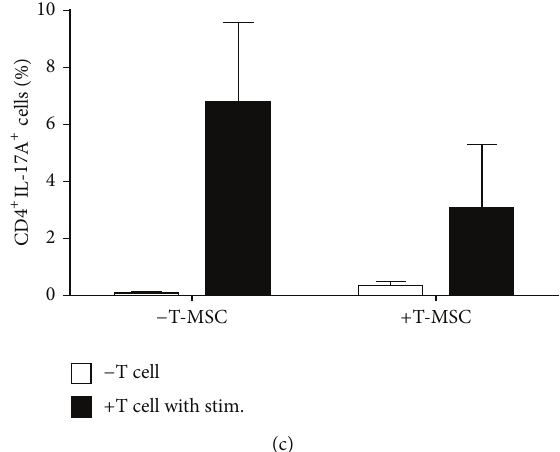
Figure 3: T-MSCs inhibit DC-mediated T cell proliferation and differentiation of the CD4 + T cell subset. (a) T cells were isolated from mouse spleens (BALB/c, 8-week-old, female) using MACS. (b) T cells were cocultured with mature DCs in the presence or absence of T- MSCs, and differentiation into CD4 + T cell subsets was induced using anti-CD3 and anti-CD28 antibodies. T cell numbers were increased upon coculturing with mature DCs. In the presence of T-MSCs, however, T cell proliferation was inhibited by 80%. (c) Differentiation into Th1, Th2, and Th17 cells also was decreased upon addition of